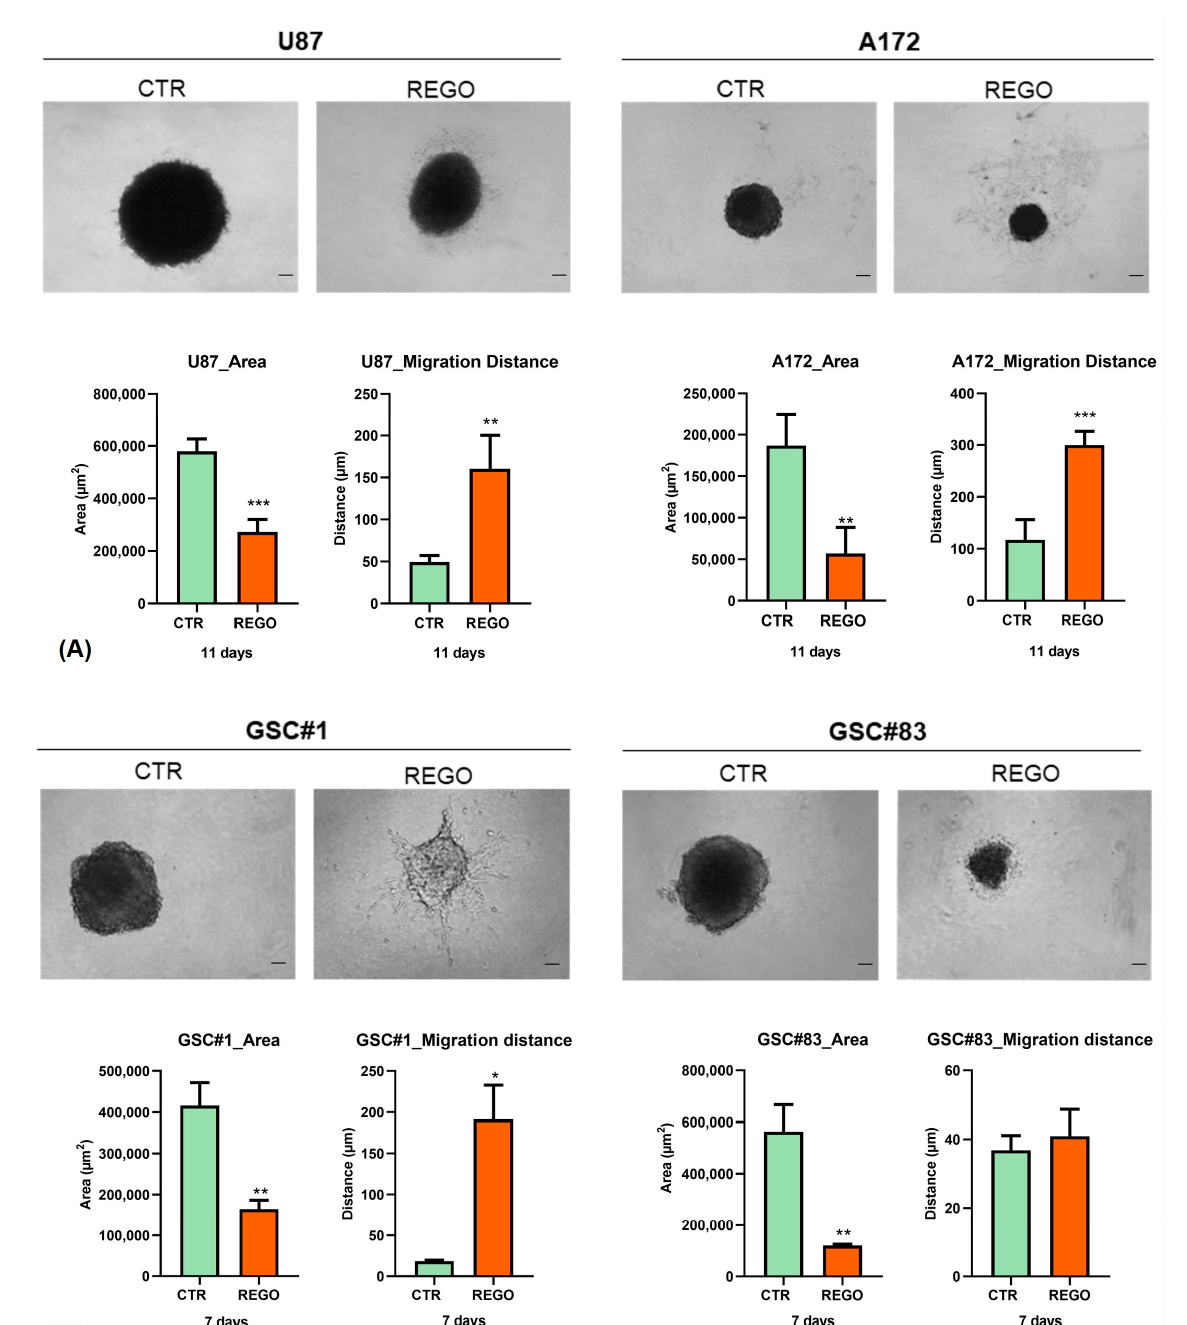
Figure 6. Regorafenib effect on 3D spheroid cultures. Regorafenib, besides limiting spheroid growth, has a pronounced effect on the invading phenotype, visible as the induction of thin branches at spheroid edges (( A , B ), upper panels). Spheroid area is negatively affected by regorafenib. Migration distance, which is a measure of the invading ability of tumor cells, is increased by regorafenib (( A , B ), lower panels). n = 5 biological replicates. * p value < 0.05; ** p value < 0.01; *** p value < 0.001. Magnification 4×, scale bar 100 μ m.